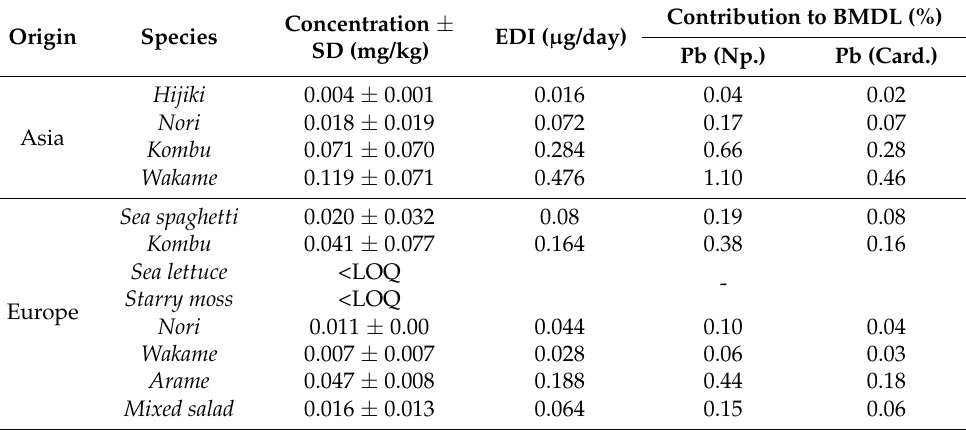
Table 5. Lead concentrations, estimated intake (EDI), and percentage contribution to the guideline value of the analyzed